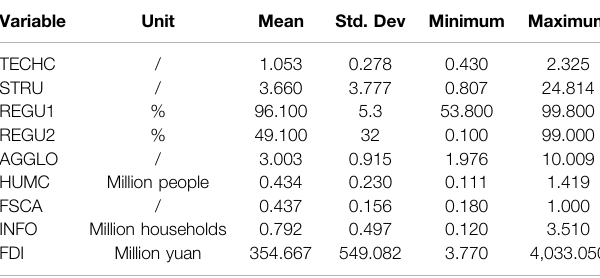
TABLE 3 | De fi nition of variables and descriptive statistical